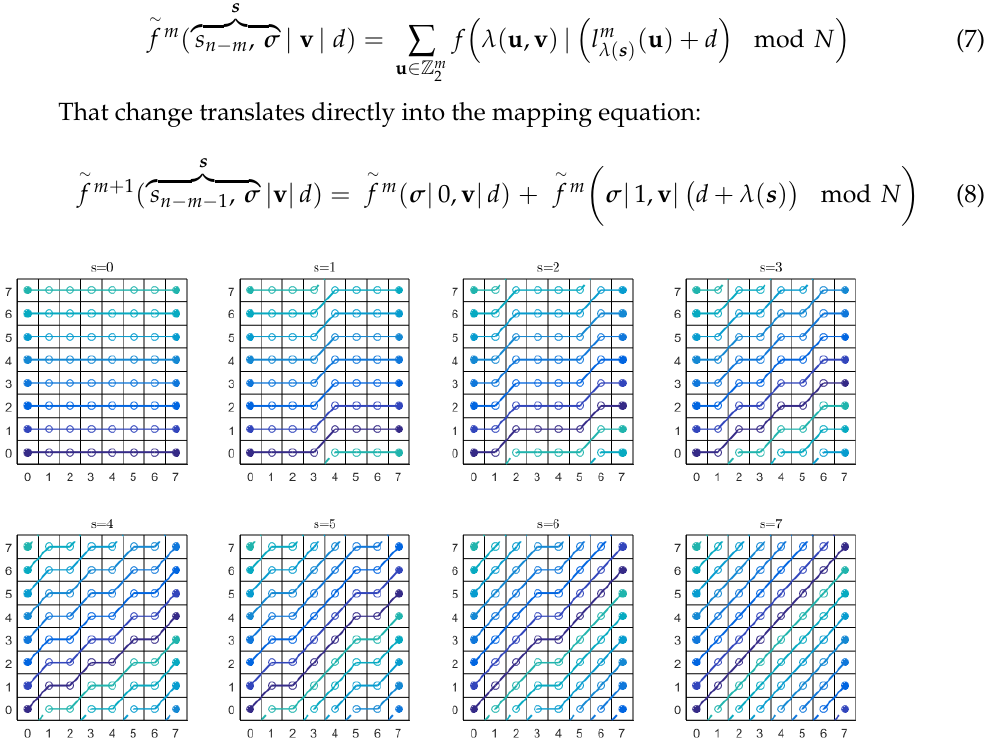
Figure 13. A depiction of the whole set of discrete lines covering the displacements and slopes, as computed by periodic